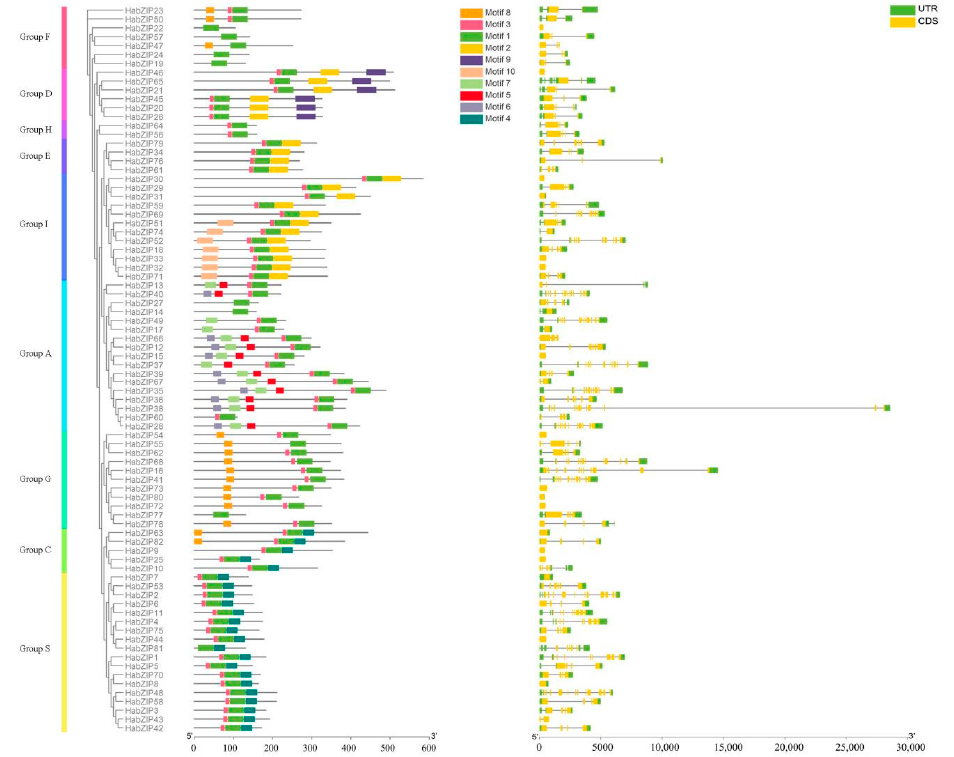
Figure 5. Sequence analysis and gene structure of